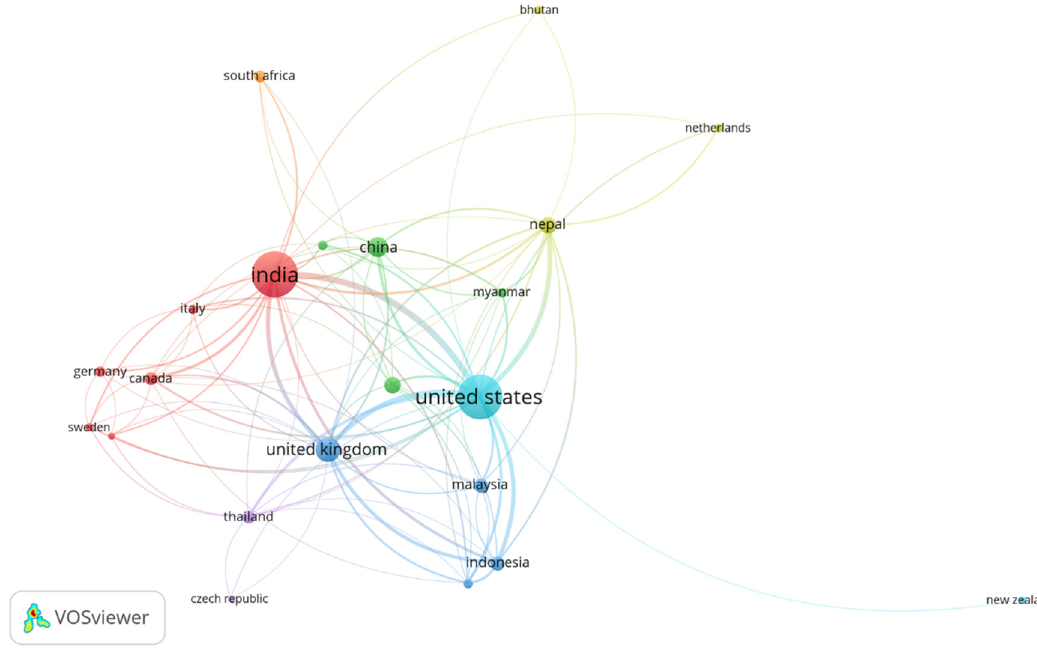
Figure 2: This fi gure shows the inter - networking of countries producing research studies in the fi eld of wildlife conservation.